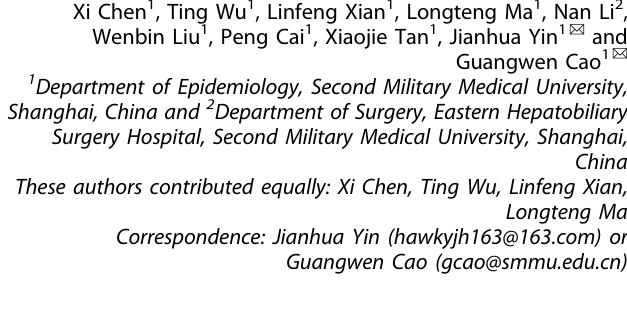
Fig. 1 circGLS2 inhibits HCC recurrence. a The design of multi-omics analysis for HCC patients with and without postoperative recurrence. b Validation of circGLS2 ’ s circular structure. PCR experiment and Sanger sequencing were performed sequentially. The back-splicing junction site was clearly observed. RNA templates diluted for 10 folds were applied for the examination of GAPDH (Left). After treating with RNase R, circGLS2 showed non-signi fi cant changes, while GLS2 with linear structure decreased signi fi cantly (Right). c The Cox regression analysis for the factors signi fi cantly affected the recurrence of postoperative HCC. d Luciferase reporter assay (Left) and ChIP-qPCR (Right) for KLF4 in parental and KLF4-overexpressing HepG2 cells. e circGLS2 was up-regulated upon ectopic express of KLF4 in HepG2 cells. f The weight and volume changes of tumors collected from mice injected with circGLS2 siRNA- and overexpression plasmid-transfected Huh7 cells. g Subcellular localization of circGLS2. circGLS2 was localized in parental and circGLS2-overexpressing Huh7 cells. 18 S and U6 served as controls localized in the cytoplasm and nucleus, respectively. h Competing endogenous RNA network of circGLS2. The edges were color- coded and proportional to the number of experimental data listed in the miRTarBase database. i Western blot assay of PTEN and AKT. j